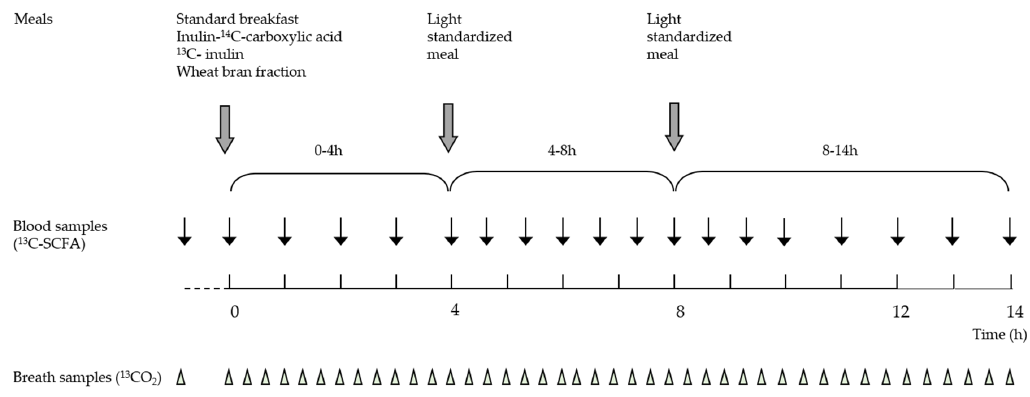
Figure 1. After a standard breakfast, labeled with 13 C-inulin, inulin- 14 C-carboxylic acid and a WB fraction, breath samples were collected for the measurement of 13 CO 2 and 14 CO 2 and blood samples were collected for the analysis of 13 C-SCFA concentrations for 14 h. A light standardized meal was administered after 4 h and 8 h. The participants were blind to the order of the different WB fractions and control tests, which were randomized.